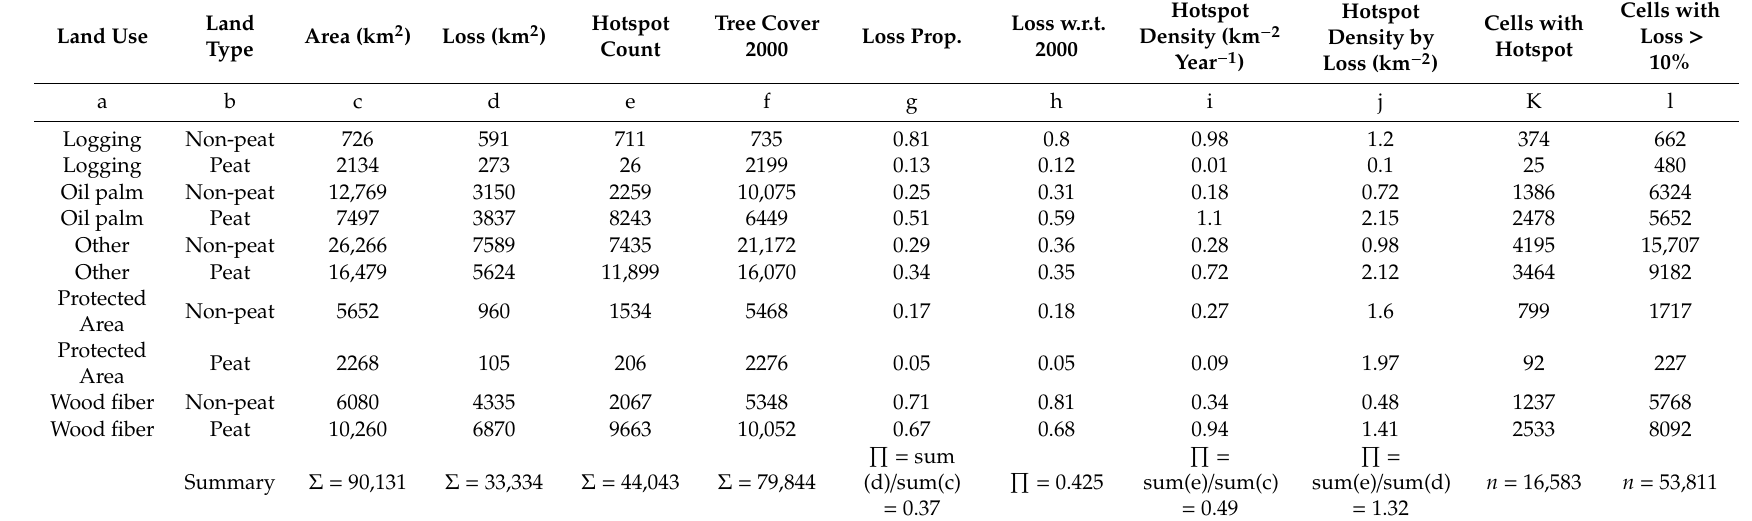
Table 4. Summary of tree cover loss and fire hotspot by land-use and land type 1